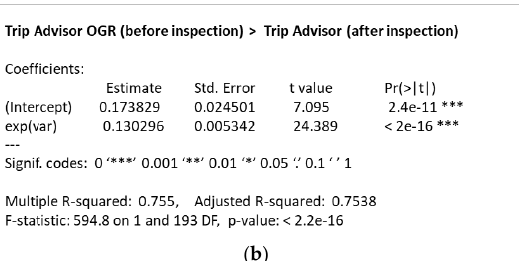
Figure 1. ( a ): Zone of improvement according to TripAdvisor OGR evolution. ( b ): Zone of deterioration according to TripAdvisor OGR evolution.